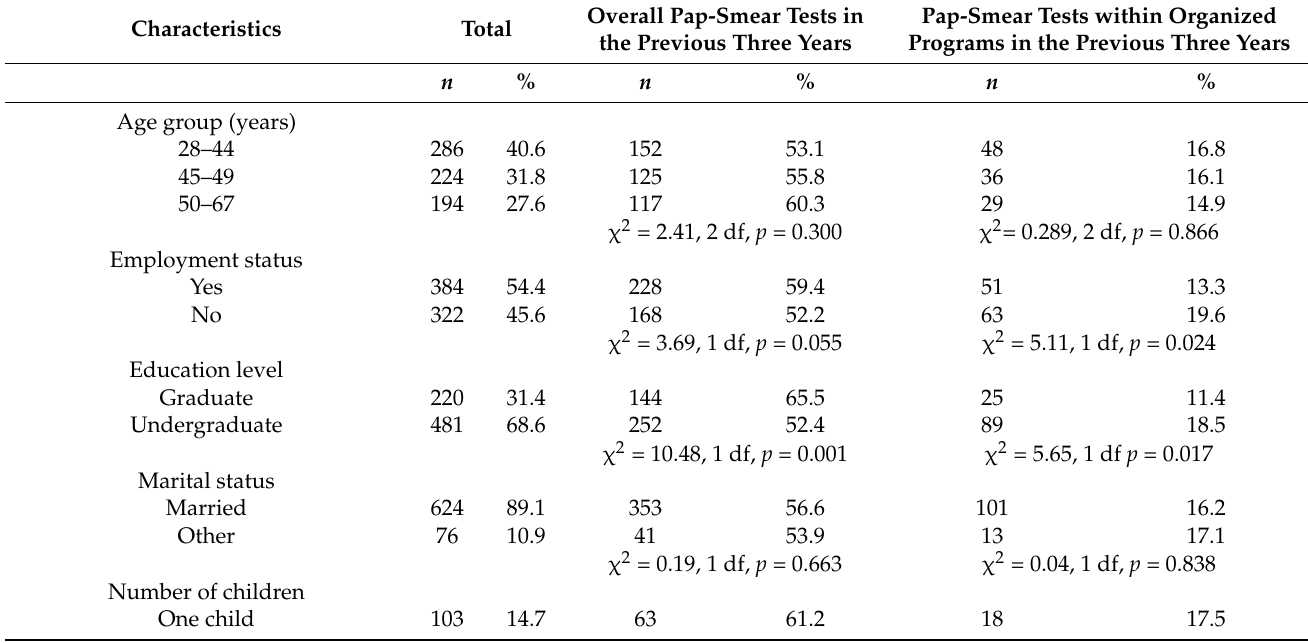
Table 1. Respondents’ socio-demographic, anamnestic and lifestyle characteristics and related Pap-smear uptake in the previous three years overall and within organized screening programs ( n =